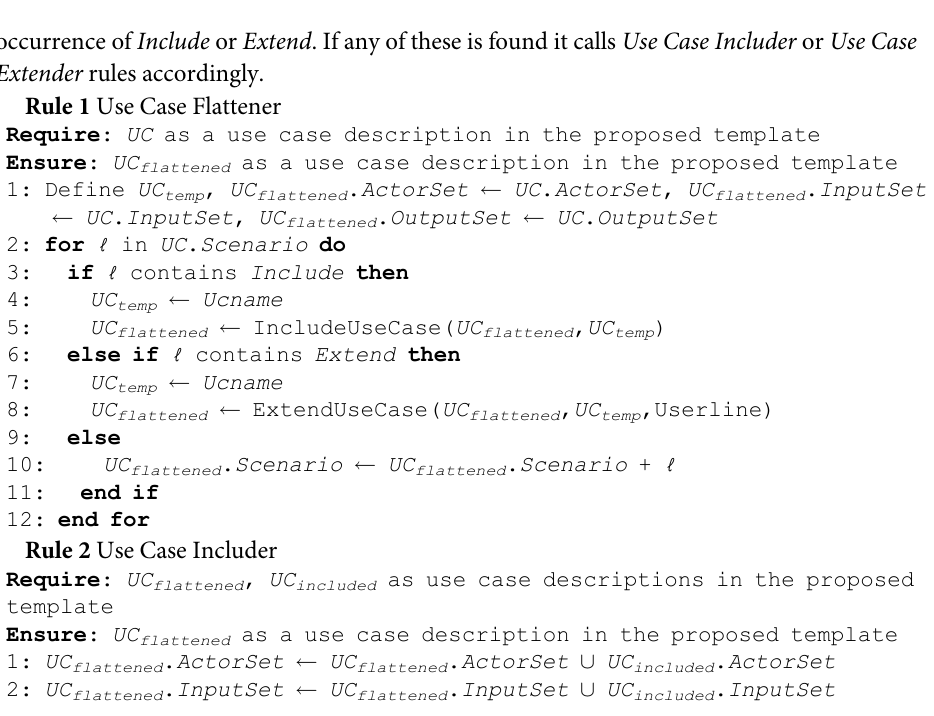
Fig 3. Context free grammar for use case